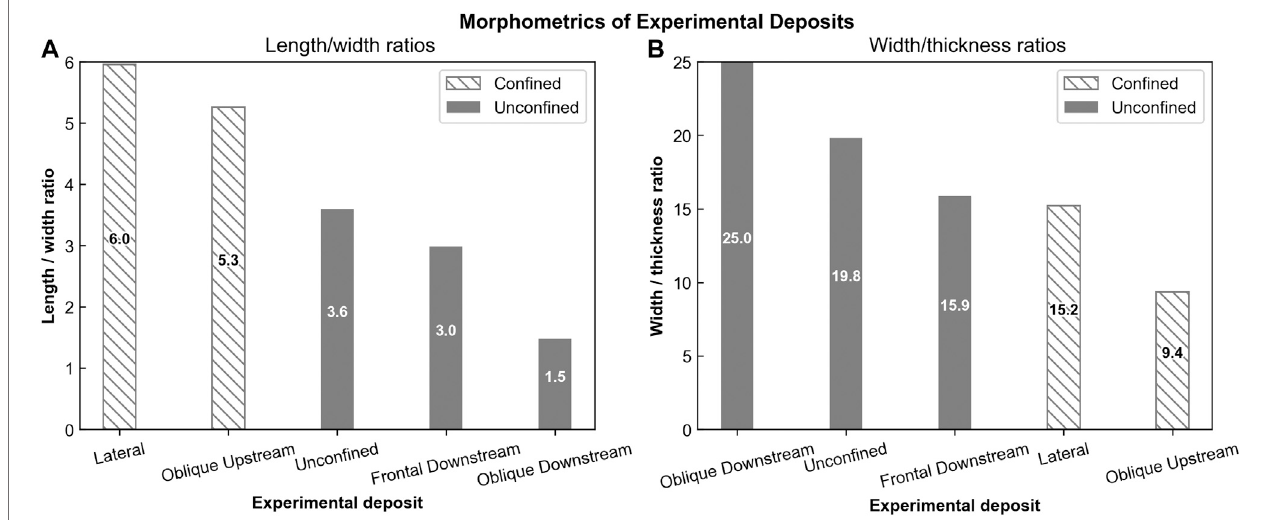
FIGURE 11 | (A) L/W ratios from experimental deposit. Lateral con fi nement results in the highest L/W ratios, while up-dip con fi nement results in the lowest L/W ratios. (B) Width-thickness ratios for each experimental deposit. Laterally con fi ned deposits have the greatest thickness-width ratios.